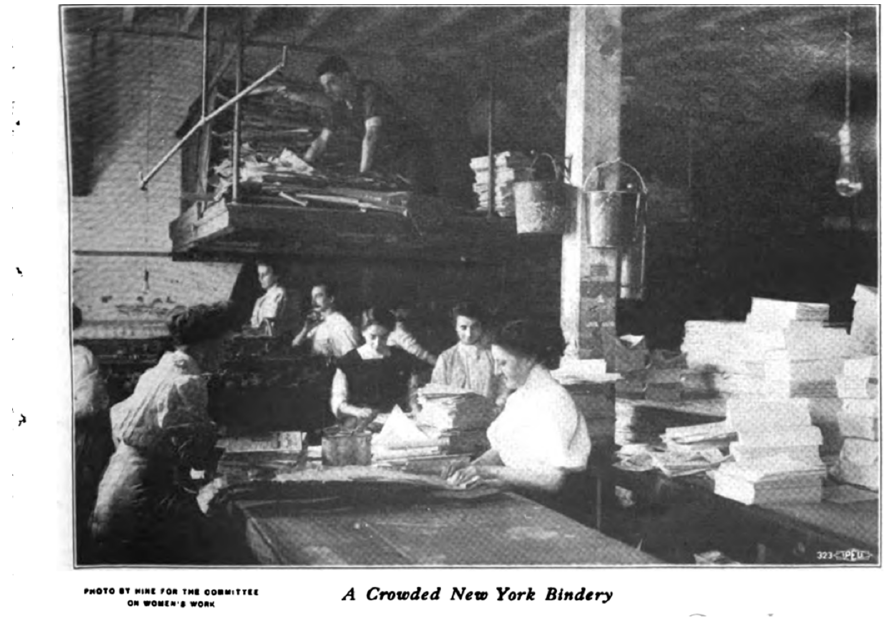
Figure 15. Lewis Hine. 1913. “A Crowded New York Bindery.” In Life and Labor (October), taken from the Russel Sage Foundation Committee on Women’s Work.